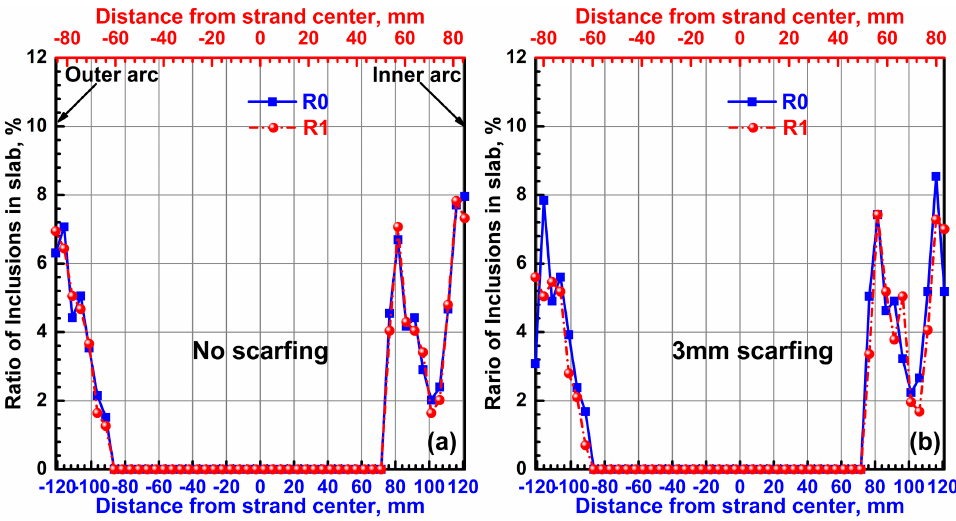
Figure 9. The inclusion distributions along the thickness direction before and after the R1 pass: the case without scar fi ng ( a ) and the case with 3 mm scar fi ng ( b ).